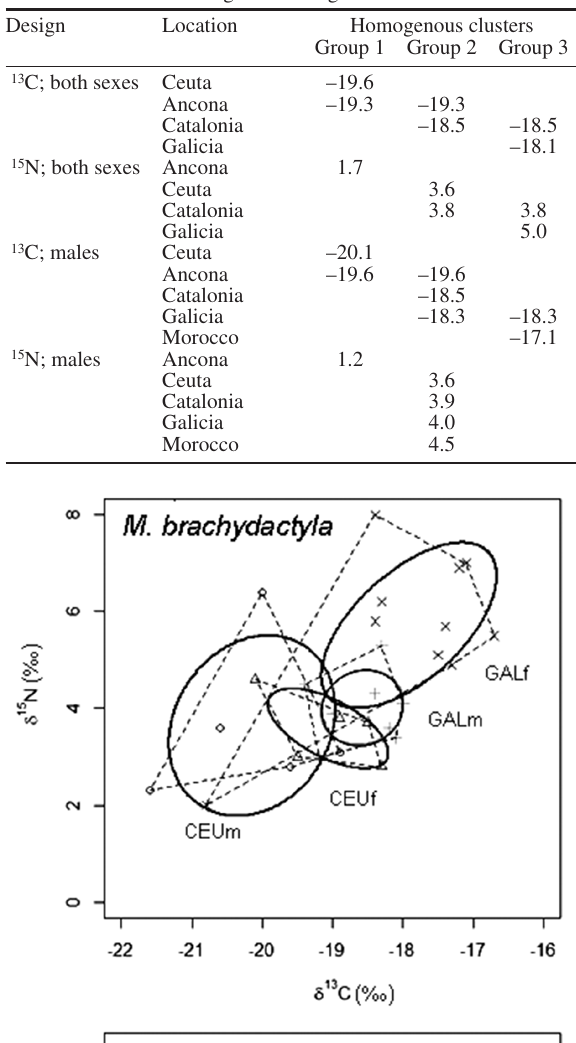
Table 2. – Results of the Tukey post-hoc tests. Values are the re- gional averages.